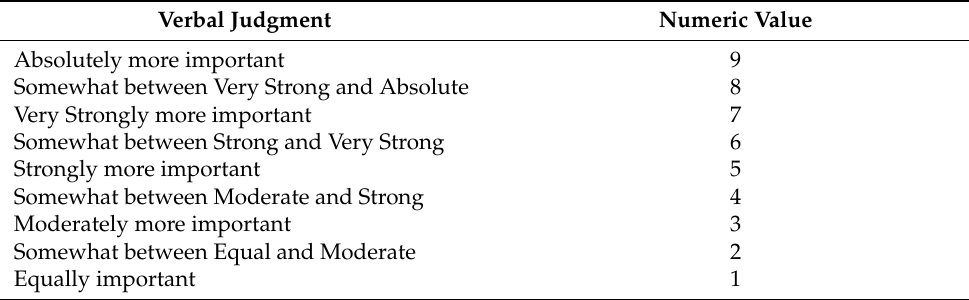
Table 3. Evaluation score for BWM technique.